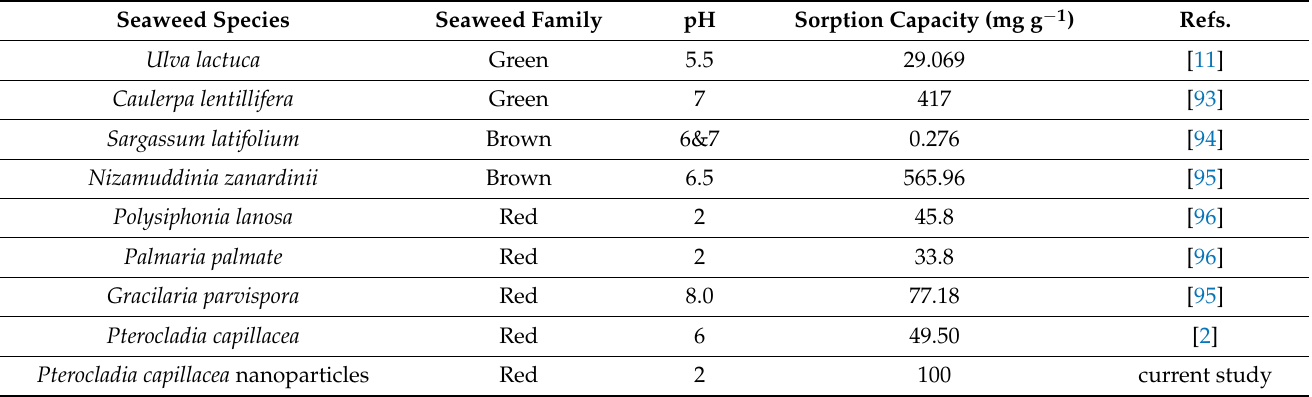
Table 7. Comparison between sorption capacities of different pollutants onto different seaweed